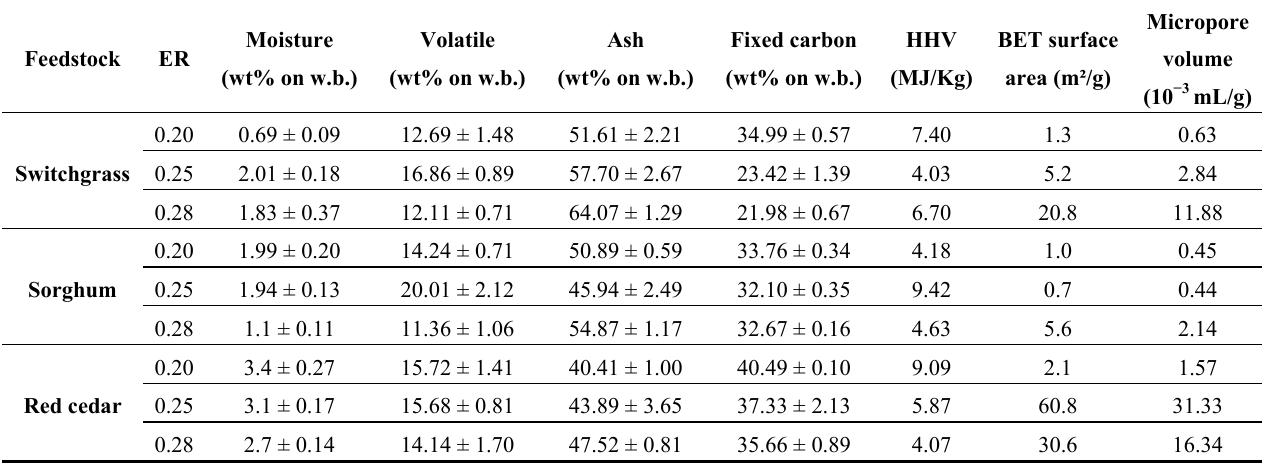
Table 2. Proximate analysis, higher heating value (HHV) and BET surface area of char derived from switchgrass, sorghum and red cedar at three equivalence ratios